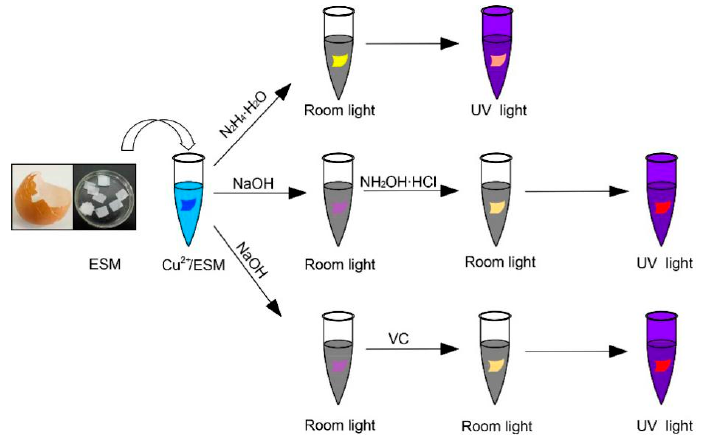
Scheme 1. Schematic representation of different synthetic routes for the in situ generation of fluorescent copper nanoclusters embedded in monolithic eggshell membrane (Cu